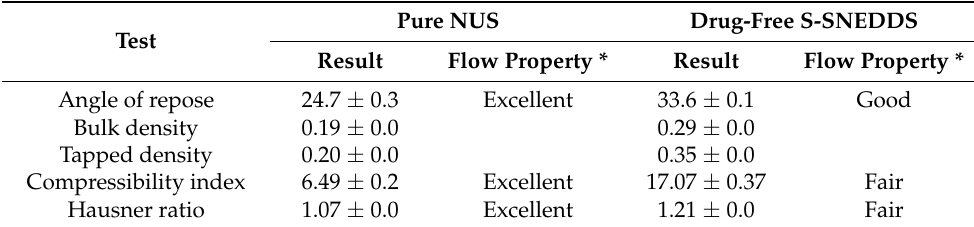
Table 2. Evaluation of powder flow properties of drug-free S-SNEDDS as compared to Neusilin US2 powder.